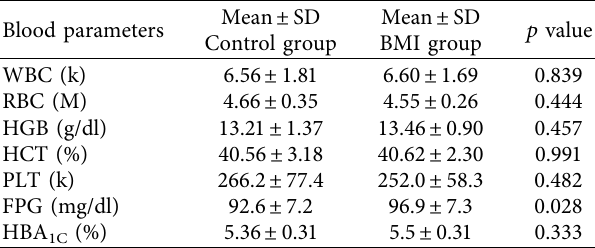
Table 2: The results of the blood parameters in both groups ( n � 47) after Bonferroni correction (adjusted p value �